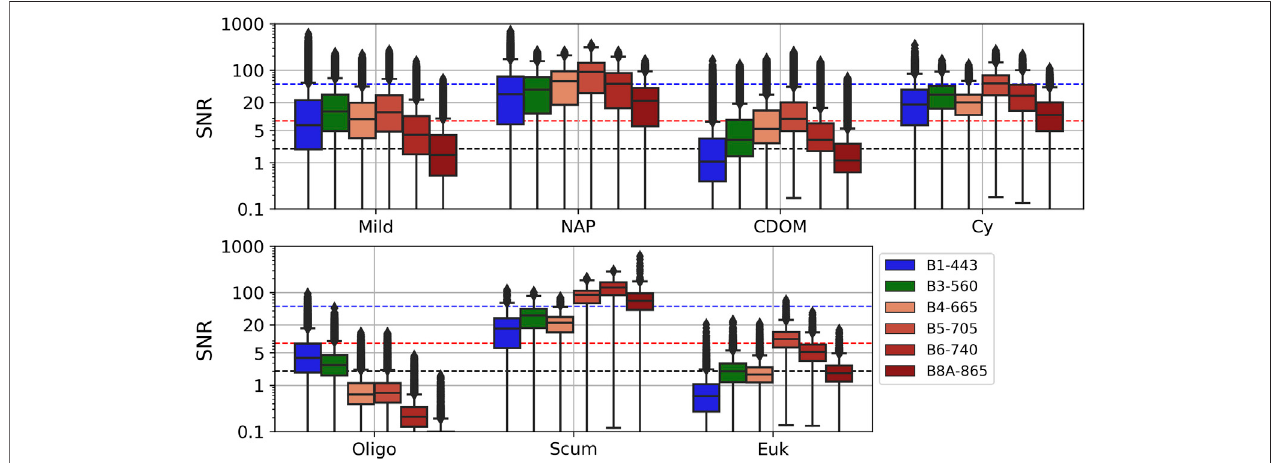
FIGURE 13 | SNR for water-leaving radiance (L w ) for S2-MSI developed using the ESA Sentinel 2 radiometric uncertainty tool (Gorroño et al., 2017; 2018) for the OWTs de fi ned in this study. The black, red, and blue dashed lines represent the theoretical research, validation, and calibration limits described in Kudela et al. (2019).